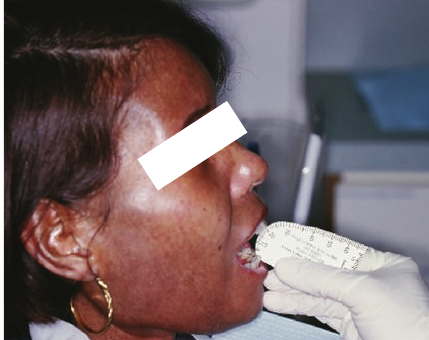
Figure 2: Improved mouth opening of 20mm following passive stretch exercises for the